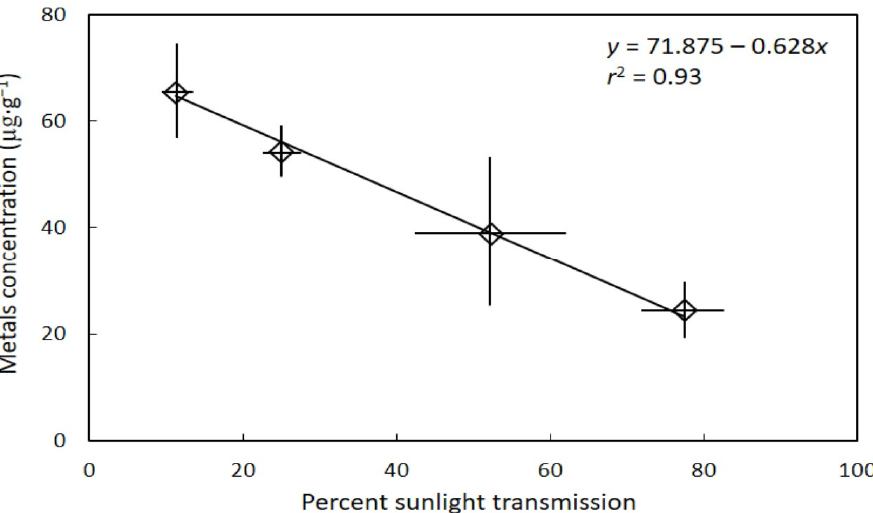
Figure 1. The influence of habitat sunlight transmission on Cycas micronesica seed gametophyte metal concentration. Total metals were the sum of aluminum, arsenic, cadmium, chromium, cobalt, lead, nickel, and selenium. Mean ± standard deviation.